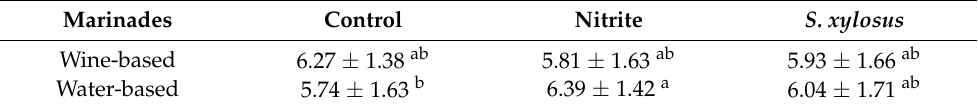
Table 2. Hedonic evaluation of cured loins. Results are presented as mean ± standard deviation. Marinades Control Nitrite S. xylosus Wine-based